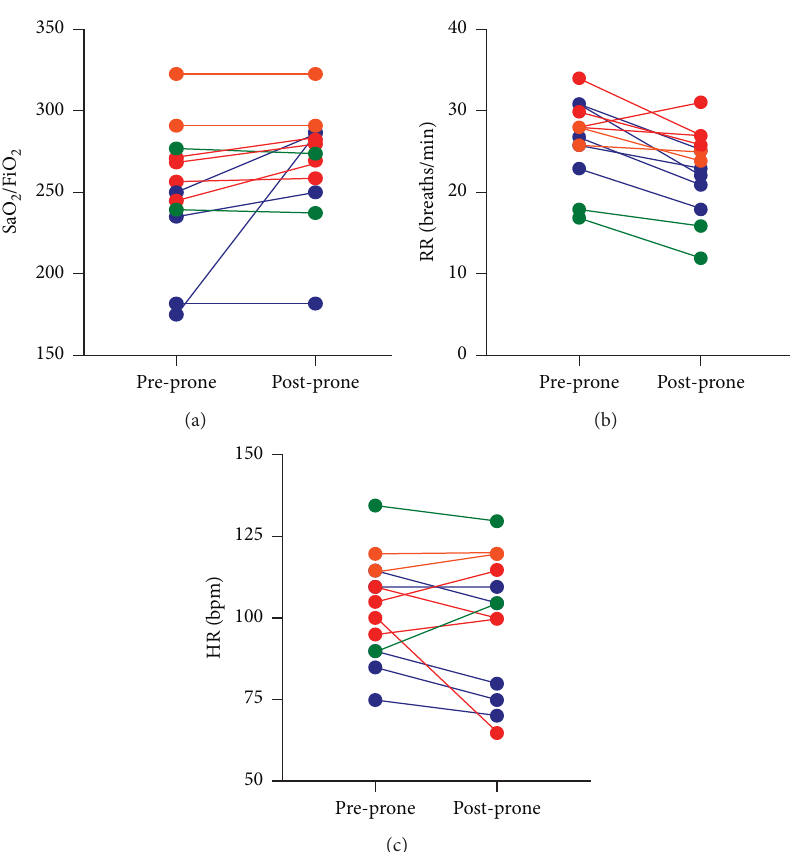
Figure 2: Individual patient values for SaO 2 /FiO 2 , RR, and HR prior to and following each prone positioning session. Each color represents a different patient: blue � patient 1, green � 2, red � 3, and orange �